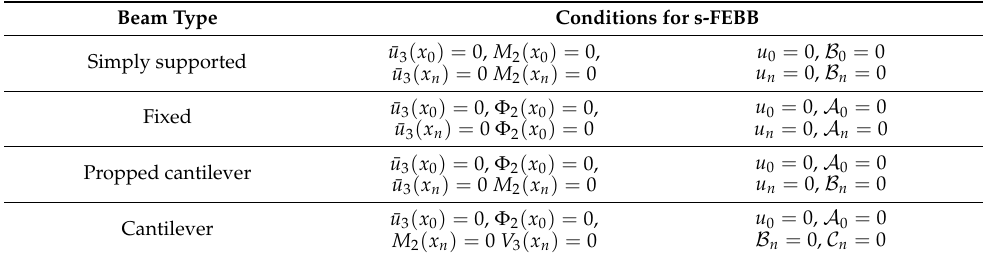
Table 2. Boundary conditions for s-FEBB applied for the selected static schemes (see also Equa- tions (18), (A12) ÷ (A14), and Figure 1).